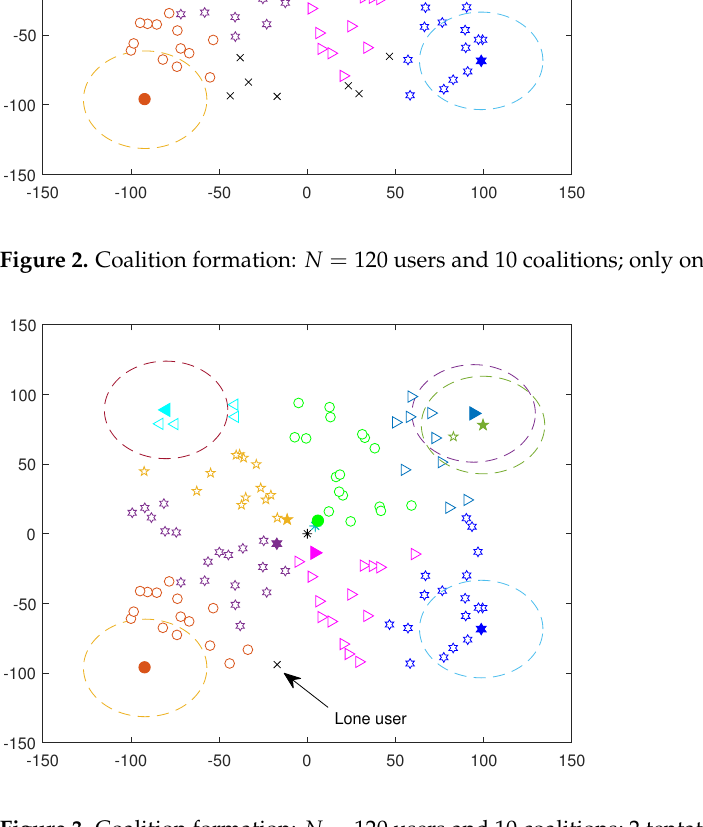
Figure 3. Coalition formation: N = 120 users and 10 coalitions; 2 tentative